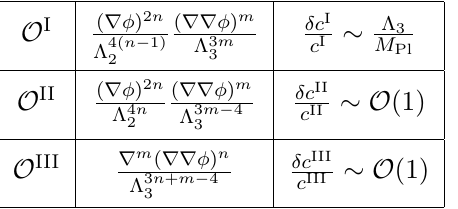
Table 1 . The power counting of higher derivative EFTs. The most general set of operators in group I is derived in section